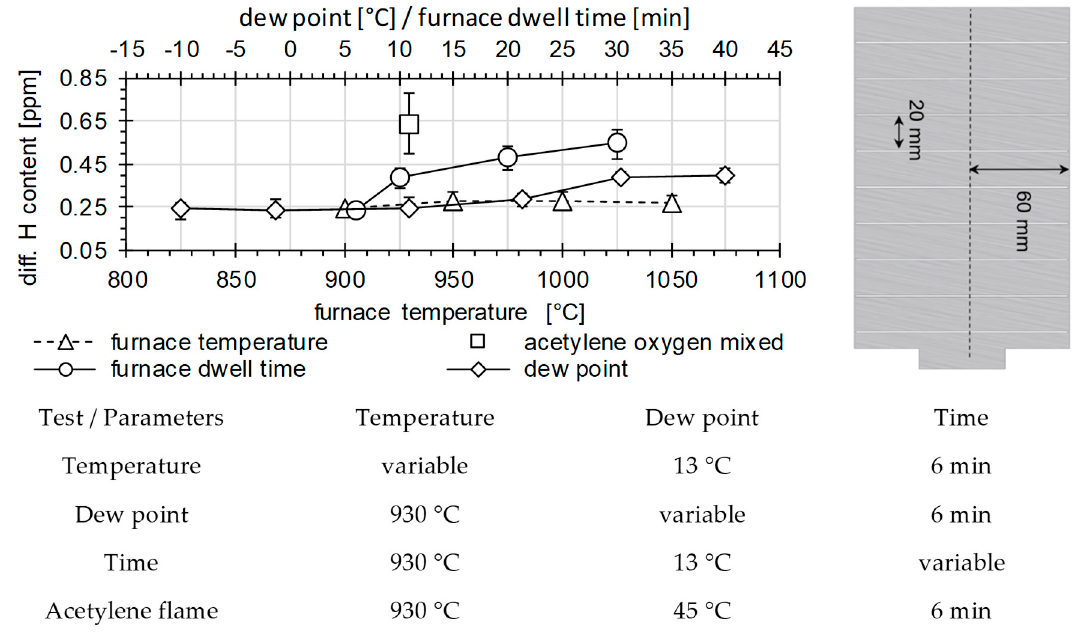
Figure 4. Hydrogen absorption during austenitisation under different conditions and sample geometry.